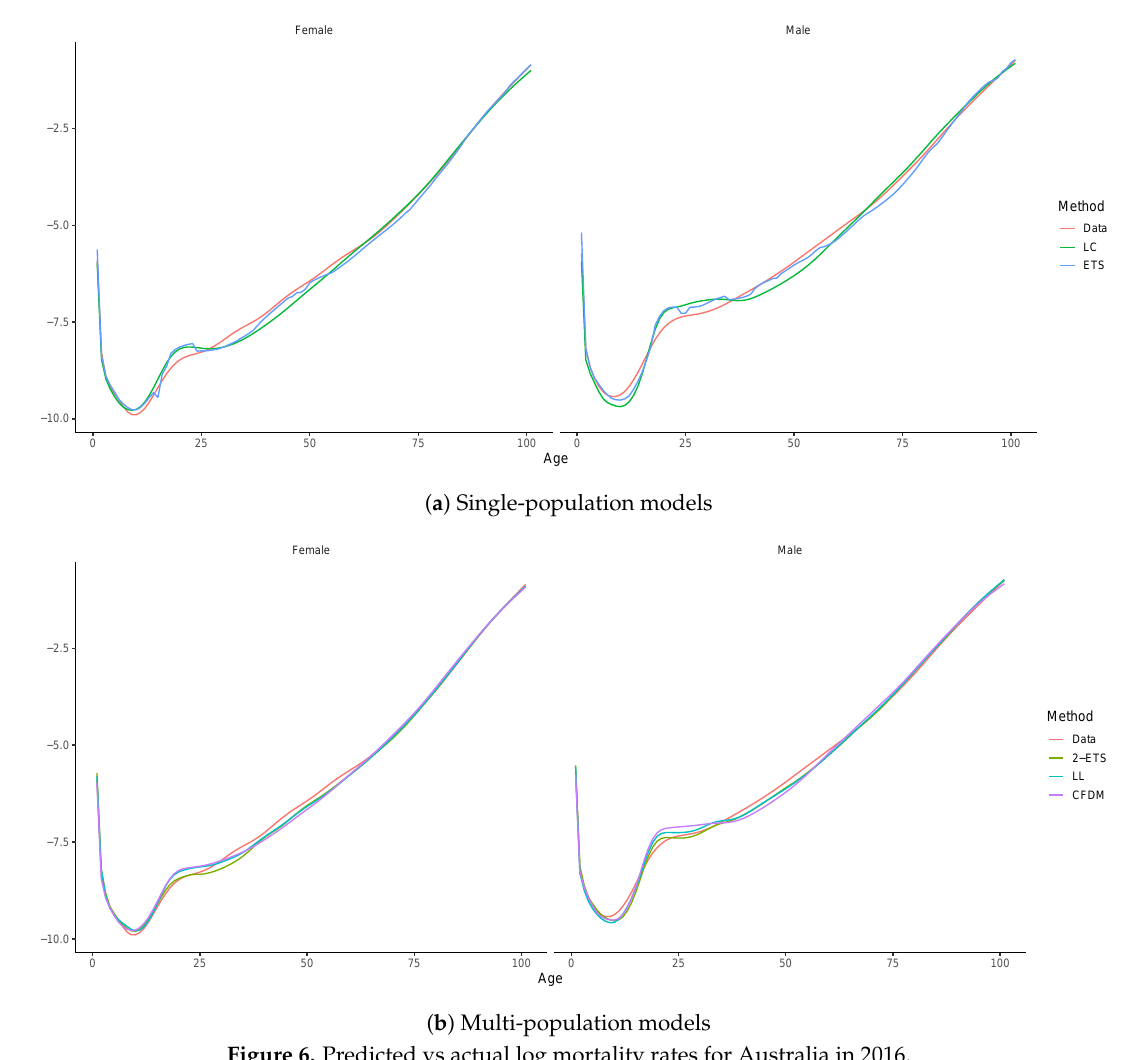
Figure 6. Predicted vs actual log mortality rates for Australia in